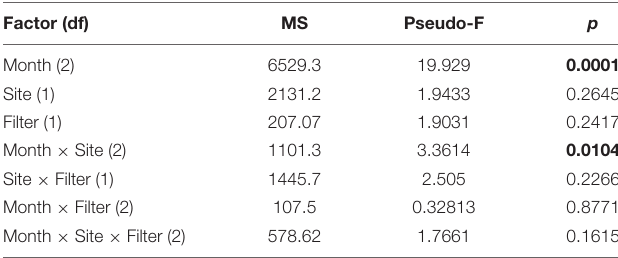
TABLE 2 | Results of PerMANOVA analysis indicating main effects and interactions of main effects. Significant differences ( p < 0.05) are in